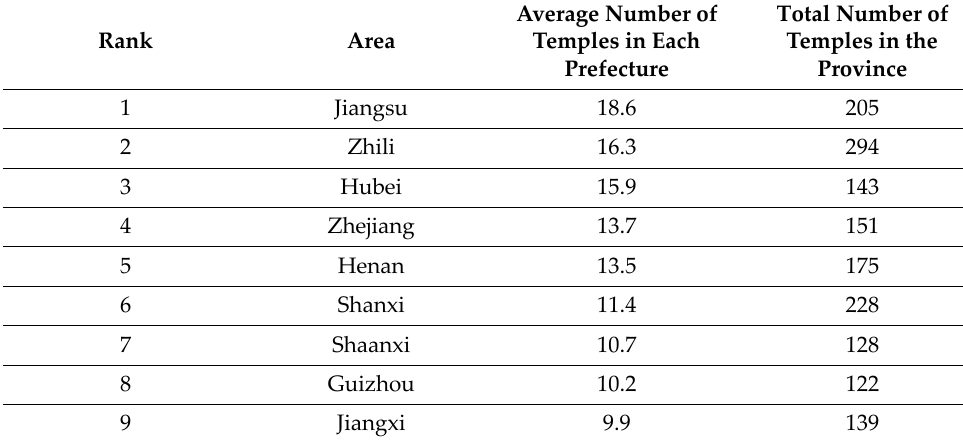
Table 8. The distribution and gender ratio of monks in each province in the first half of the 20th